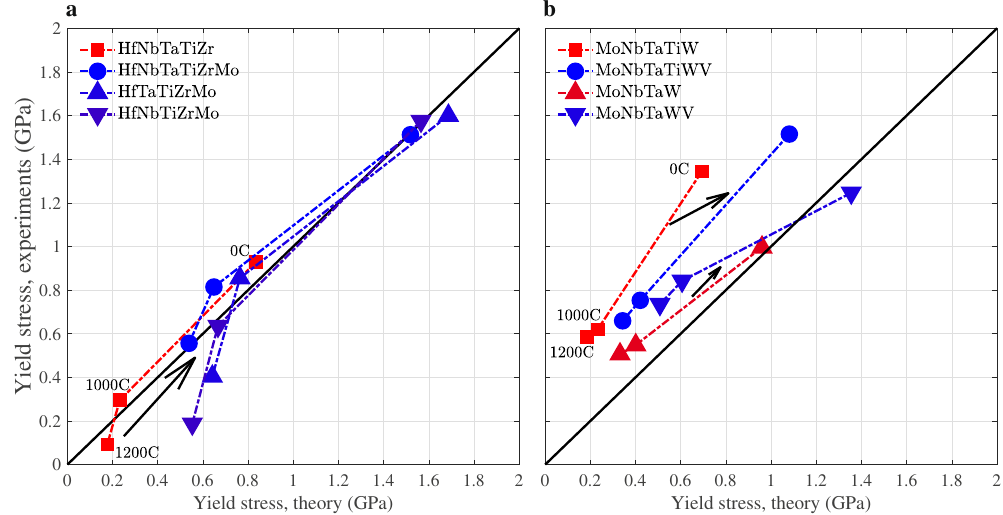
Fig. 7 Yield strength theory predictions vs experiments at 0, 1000, and 1200 ∘ C. Alloys in the a HfNbTaTiZr(Mo) family show strengthening due to Mo additions and alloys in the b MoNbTaW(Ti)(V) family show strengthening due to V